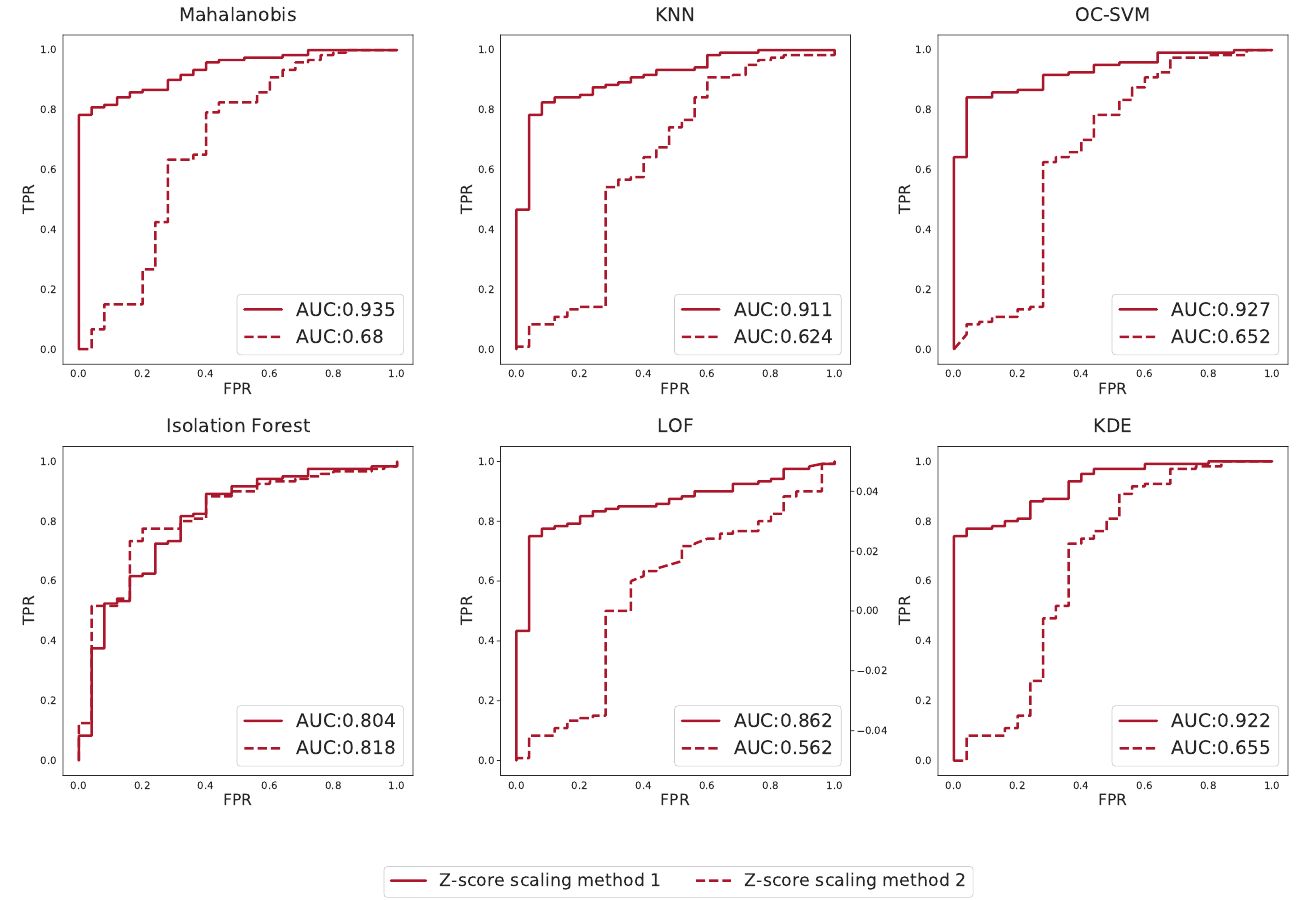
Figure A12. ROC curves and AUCs for six outlier detection methods (as indicated in the title), for two different Z-score scaling